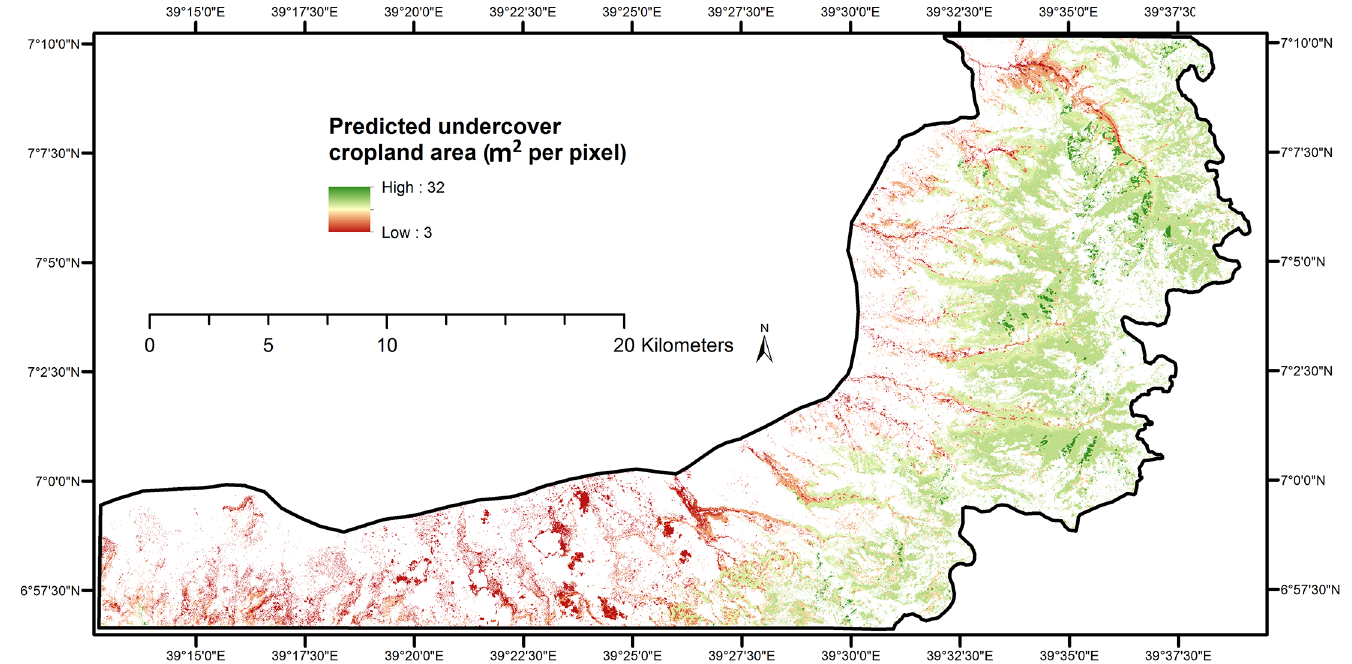
Fig 4. Undercover cropland area predicted from most influential topographic factors identified using Boosted Regression Trees. (pixel size of 100 m 2